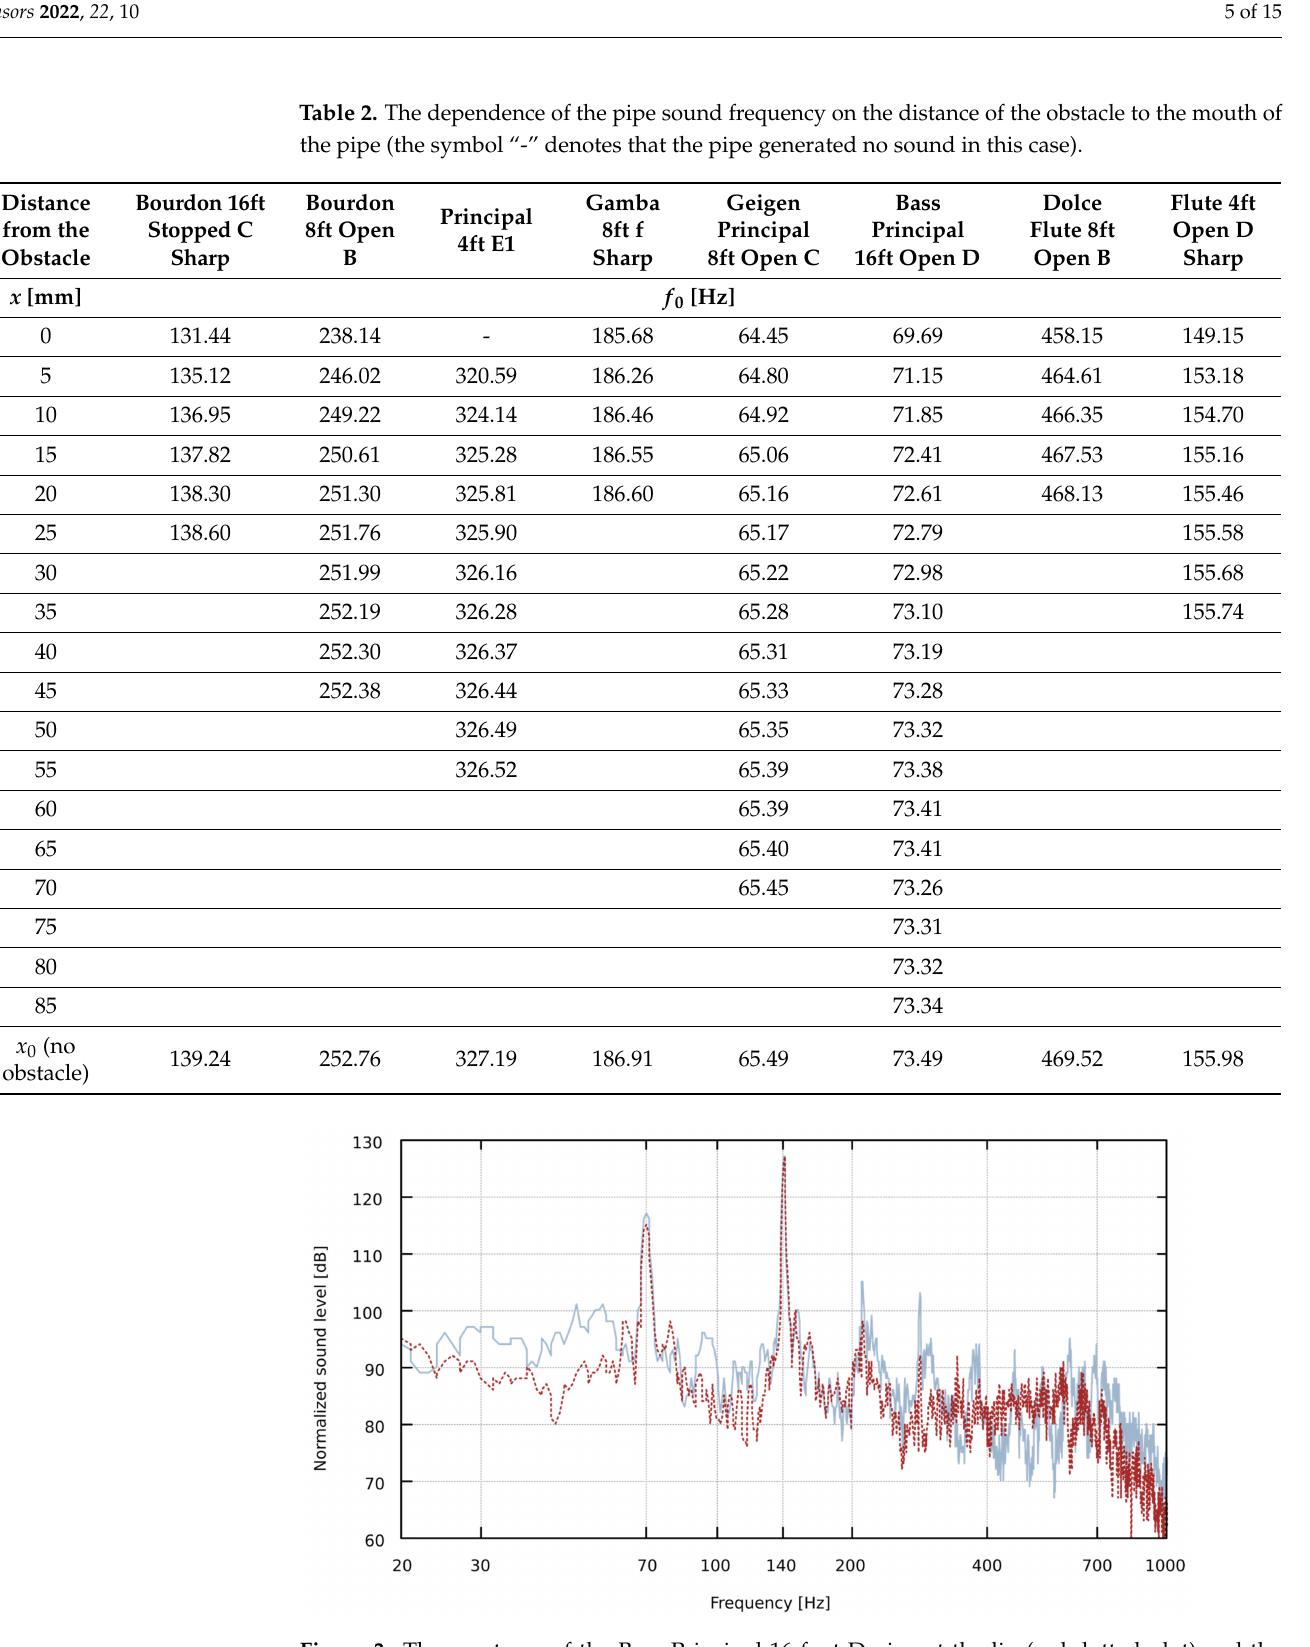
Figure 3. The spectrum of the Bass Principal 16-foot D pipe at the lip (red dotted plot) and the top (grey solid line plot) after normalization to the maximum sound level value for the immediate proximity of the obstacle (0 mm) at the pipe’s lip. As we can see, the harmonics do not overlap. The fundamental frequency, calculated by DTFT with 0.01 Hz frequency resolution, is 69.91 Hz at the lip and 69.69 Hz at the top (a difference of about 5 cents, which can be heard by a trained musician, especially when such a sound is accompanied by another playing